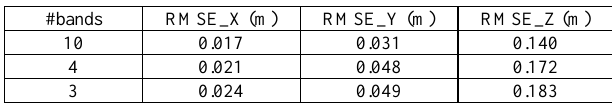
Table 6. Simulated data: RMSE in seven checkpoints using four bands and 28